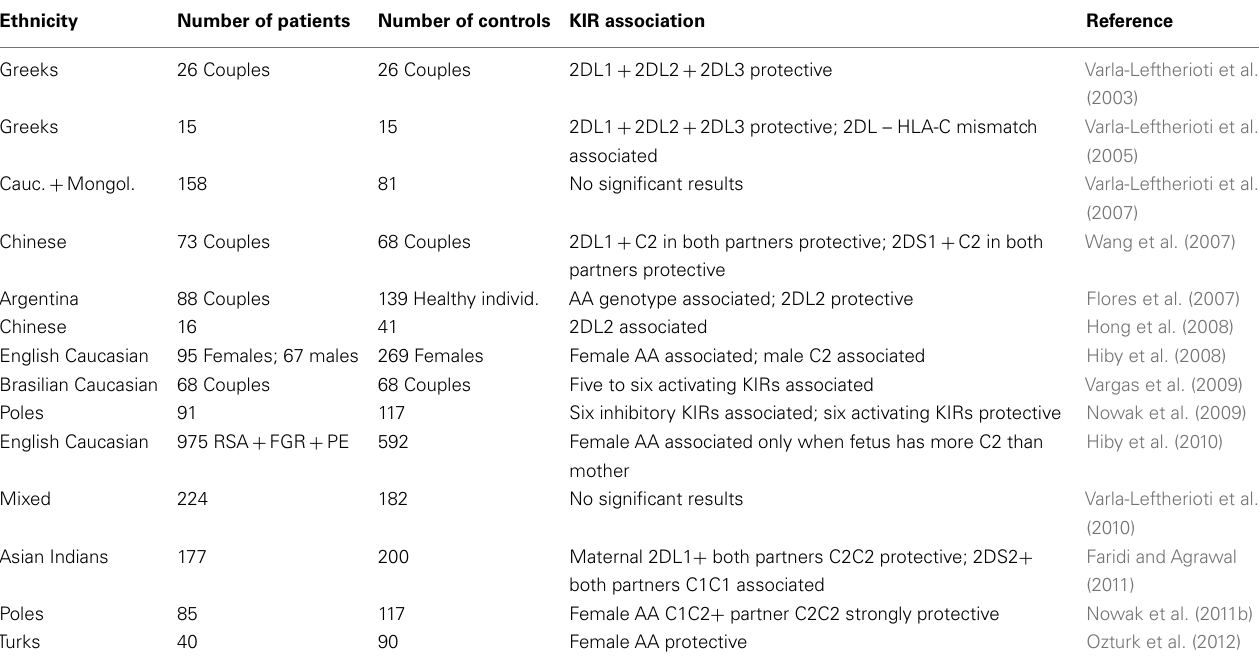
Table 3 | KIR gene associations with recurrent spontaneous